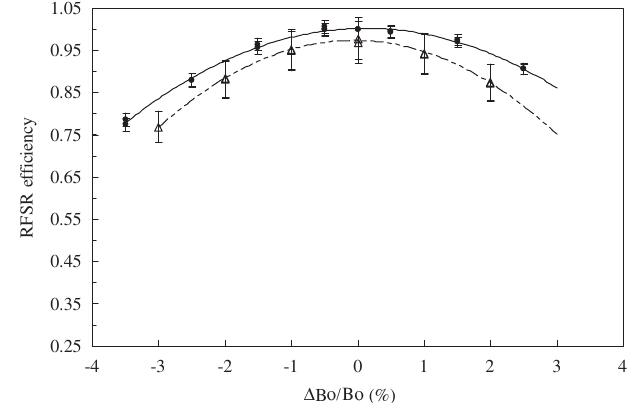
FIG. 7. Eight consecutive neutron pulses corresponding to the eight-step spin sequence ( #""#"##" ) of the RFSR measured by